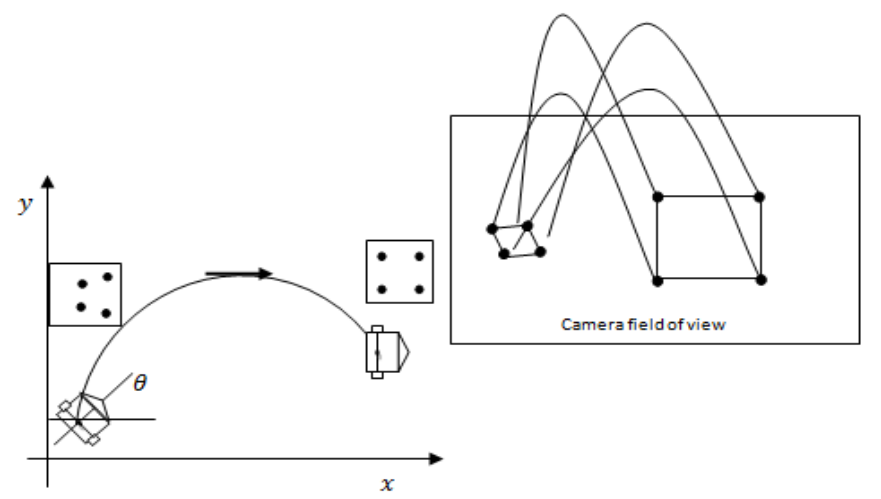
Figure 17. Case 2: Where the object leaves the field of view of the camera. Figure 18 represents the evolution of the trajectory of the robot in the image frame. It